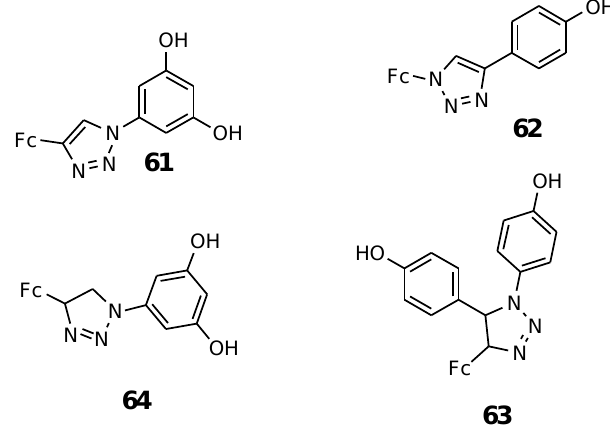
Figure 21. Chemical structures of hydroxyphenyl–ferrocephenol derivatives ( 61 – 64 ).